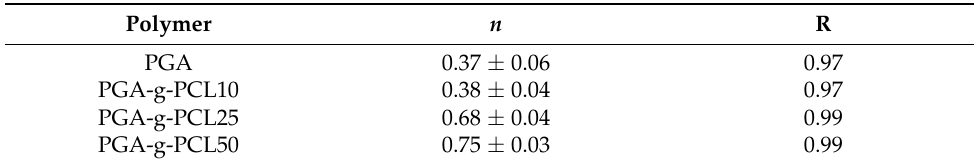
Table 3. Korsemeyer–Peppas transport exponent ( n ) and correlation coefficient (R) for the UA-loaded